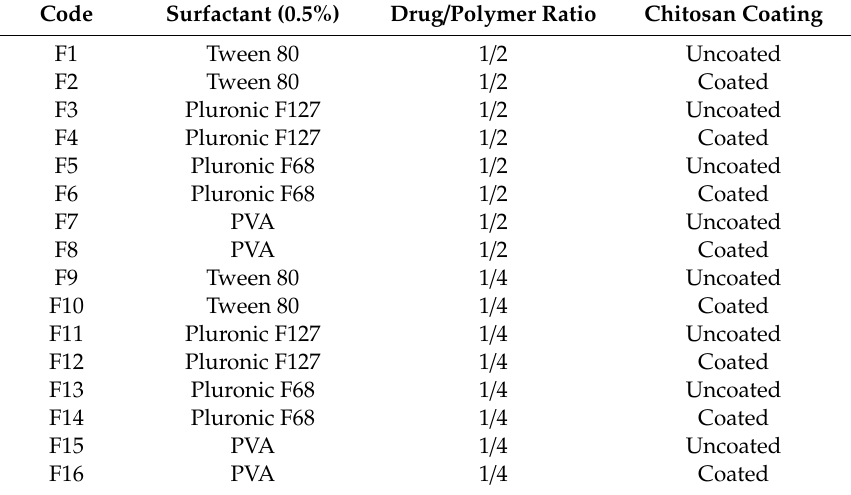
Table 1. Compositions of di ff erent paliperidone (PP)-loaded polycaprolactone (PCL) nanoparticle